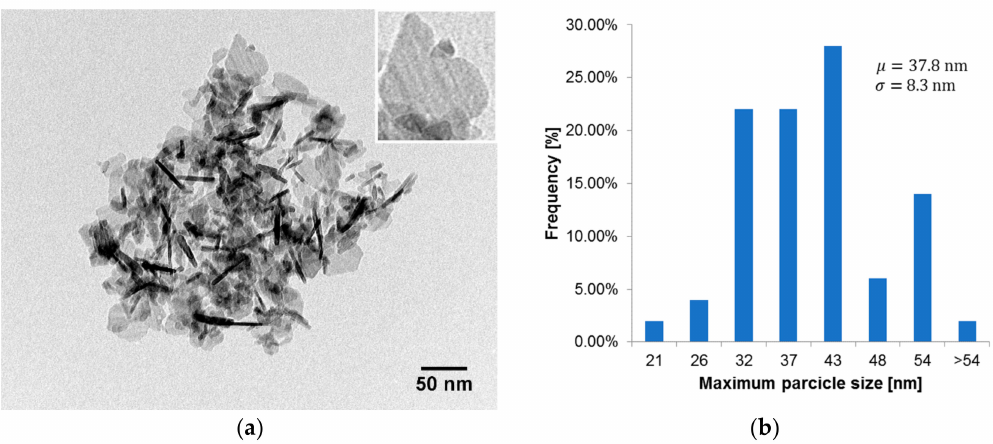
Figure 4. View of: ( a ) the transmission electron microscope (TEM) image of Al 2 O 3 nanopowder particles; ( b ) the particle size distribution of Al 2 O 3 nanopowder.